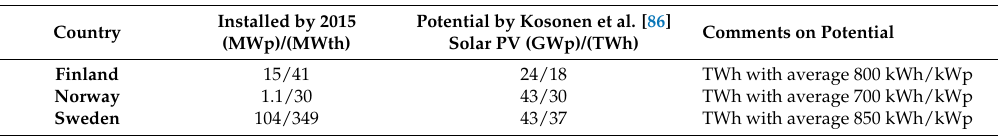
Table 7. Solar energy—installed capacity in 2015 (solar PV and solar thermal), solar PV market potential by 2050 [86] (installed capacity and estimated solar energy